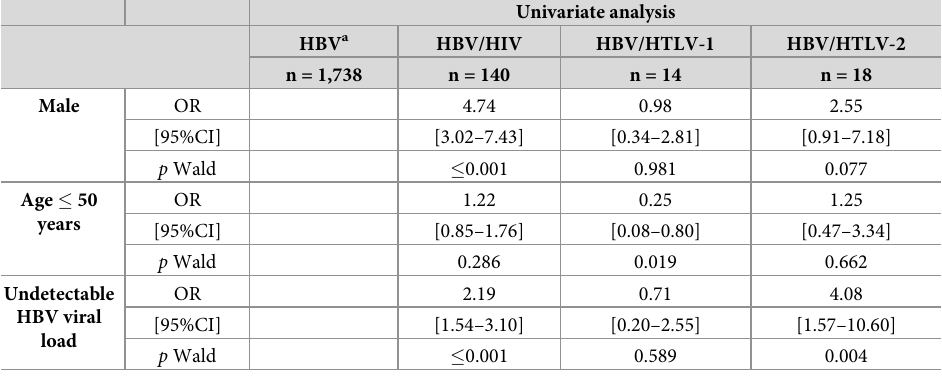
Table 3. Factors associated with undetectable HBV viral load in HBV infection and coinfection at the beginning of